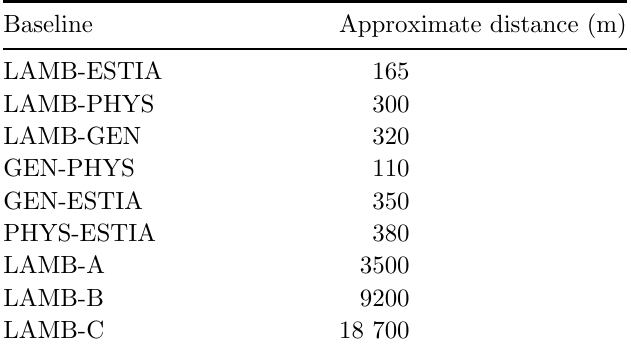
Fig. 2. (a) View of the test control network (Google map). (b) View of the long baseline test area (Google map). Table 3. Baseline approximate